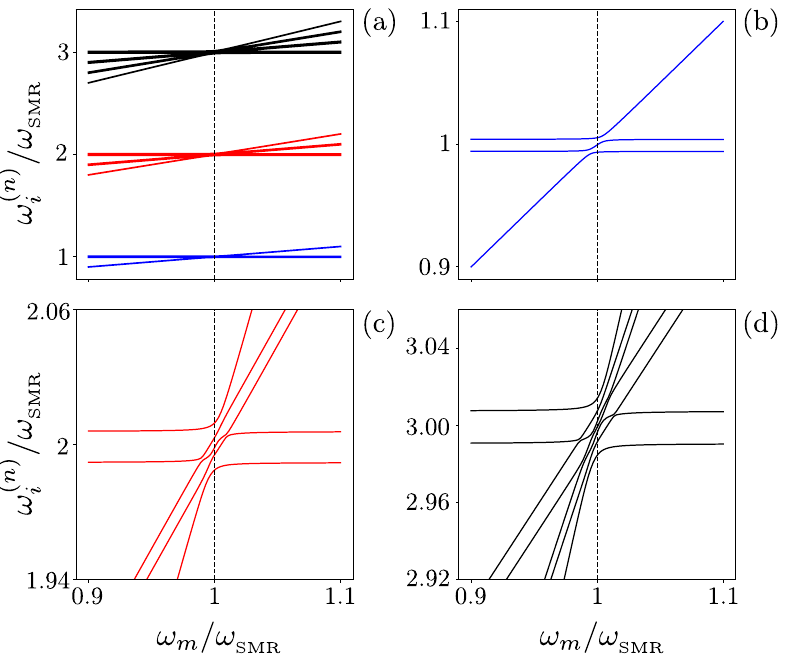
Figure 2. Energy levels ω n versus the QD frequency ω m in units of the SMR frequency ω Hamiltonian Eq. (2) with the parameters given in Eq. (28) and g energy levels in panel ( a ) are zoomed in panels ( b – d ) near the resonance ω m of energy levels. Here, ω